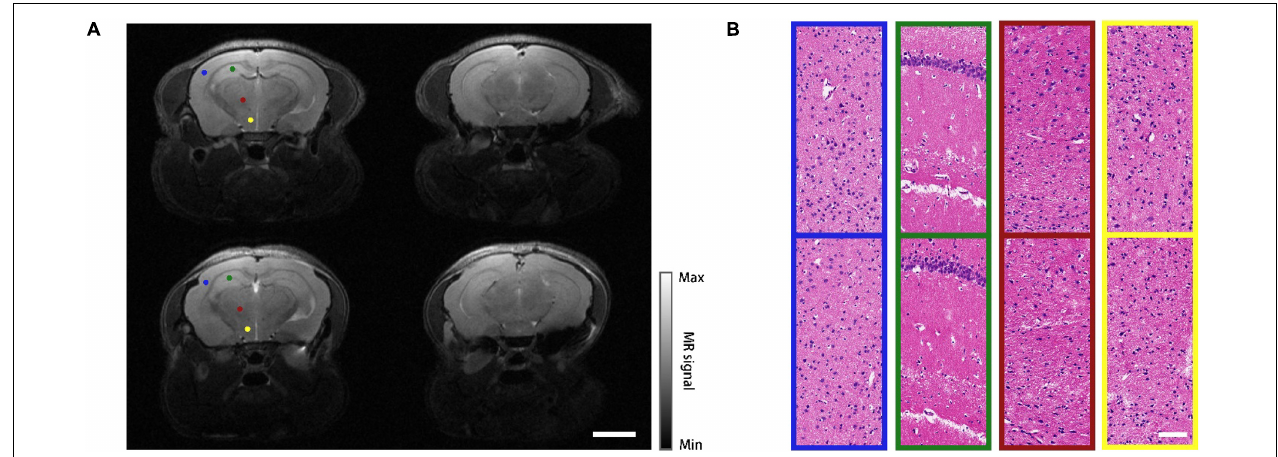
FIGURE 3 | MRI and histopathology results. (A) MRI images of a normal mouse (top row) and a modeled mouse (bottom row), left column shows midbrain, right column shows hindbrain. Scale bar = 3 mm. (B) H&E stained images of different regions in midbrain coronal plane. Top row: normal mouse; bottom row: mouse model. The sampling regions of these images are represented as color-coded dots in (A) . Scale bar = 80 µ m.